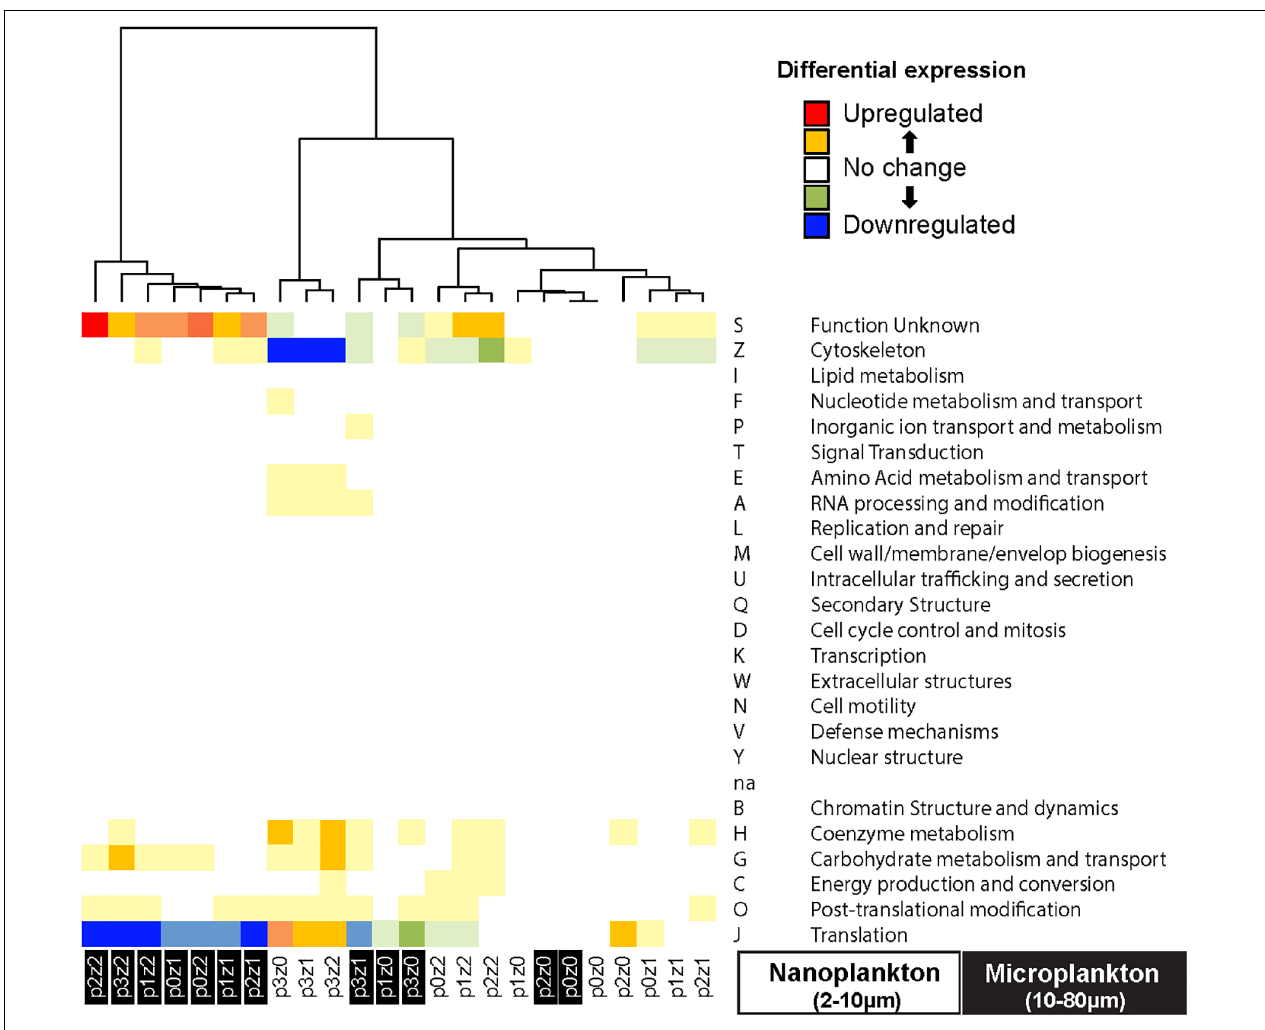
FIGURE 5 | Heatmap of differential gene expression of the transcripts grouped by clusters of orthologous groups (COG) indicates downregulation of transcript expression related to translation (GOG J) in the microsized plankton incubated with copepods, while nanosized plankton show a downregulation of cytoskeleton (COG Z) function incubated with phytoplankton bloom. The microsized plankton show an upregulation of protein with unknown function (COG S, almost all involved in fucoxanthin chlorophyll a/c pathway in our data). The clustering of the samples is based on Euclidean distance and WardD algorithm. See Figure 1 for details about sample